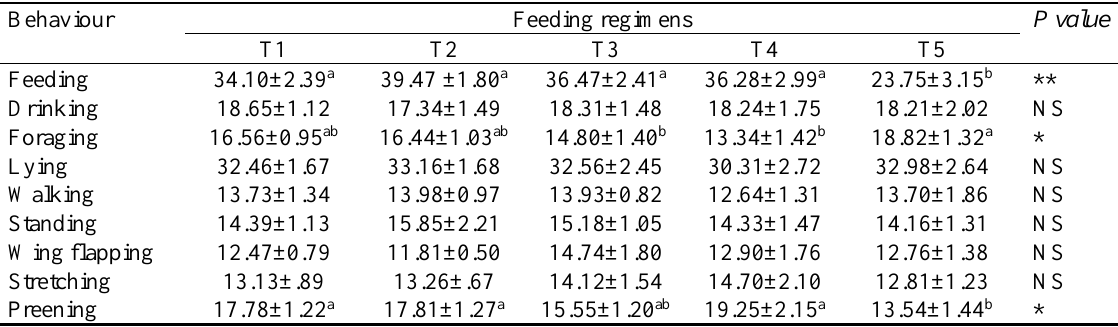
Table 4: Effect of feeding frequency and amount on behaviors (%) of broiler (Means±SE). Behaviour Feeding regimens P value